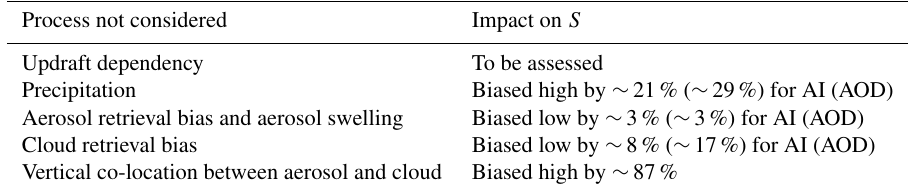
Table 3. Issues highlighted in this study and their impacts on the overall estimation of S